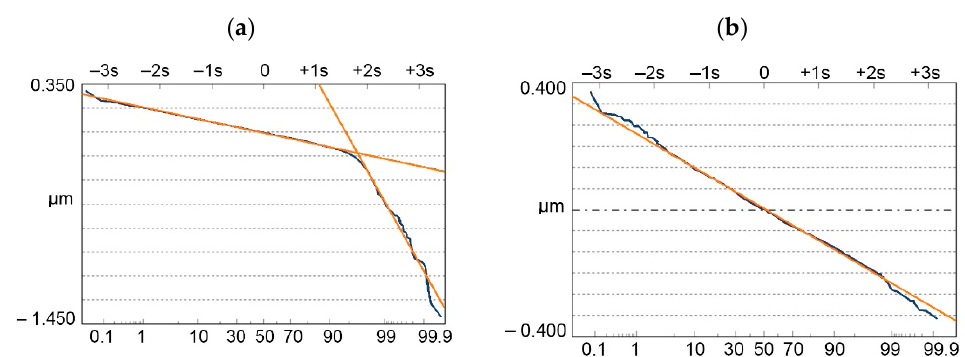
Figure 17. Cumulative plot of the distribution of the asperity heights of surfaces characterized by the following parameters: Spq = 0.1 µm, Svq = 1 µm, Smq = 84.13% and CLp = 25 µm and CLv = 125 µm ( a ) CLp = 12.5 µm and CLv = 12.5 µm ( b ), adapted from [167].